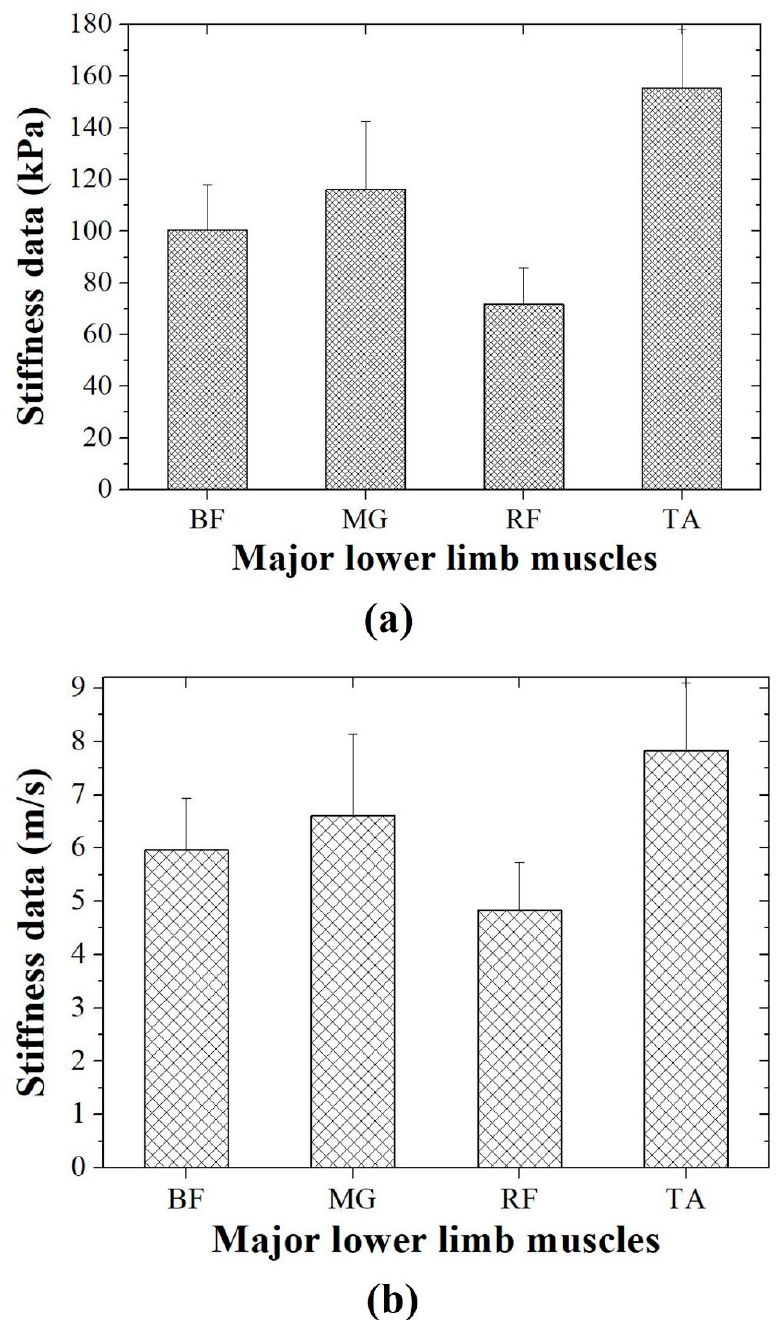
Figure 3. Acquired stiffness data in ( a ) kPa and ( b ) m/s in shear wave elastography for major lower limb muscles (BF: biceps femoris, MG: medial gastrocnemius, RF: rectus femoris, TA: tibialis anterior).